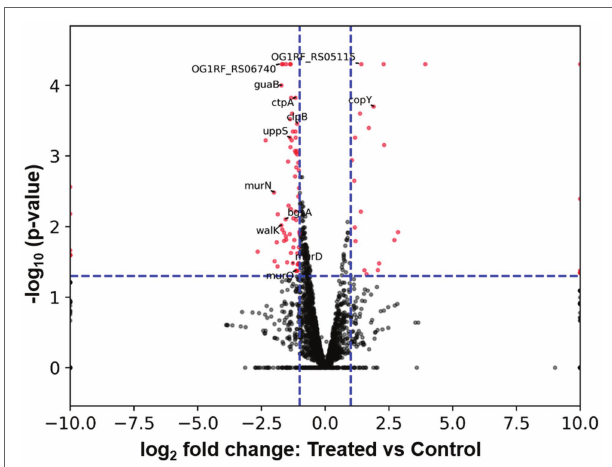
FIGURE 7 | Volcano plot from RNA-seq data showing DEGs of E. faecalis in response to B. subtilis natto supernatant. The expression of each gene is represented by dots. Genes with a value of p ≤ 0.05 and an FC ≥ 2 were considered significantly differentially expressed (represented by red dots). The horizontal blue dashed lines indicate the positions on the Y axes for a -log 10 (value of p = 0.05), and the vertical blue dashed lines indicate the positions on the X axes for a ± log 2 (FC = 2). The 13 DEGs labeled in the volcano plot were selected for further RT-qPCR analysis.